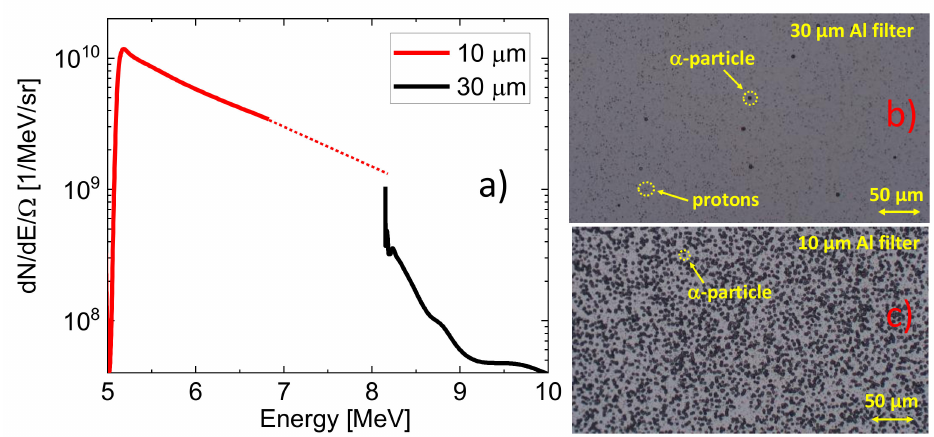
Figure 3. ( a ) The experimental spectrum of the α -particles that were emitted in the backward direction from the target’s front surface; ( b ) the corresponding CR39 raw image in the case of the 30- µ m Al filter and ( c ) the 10- µ m Al filter.